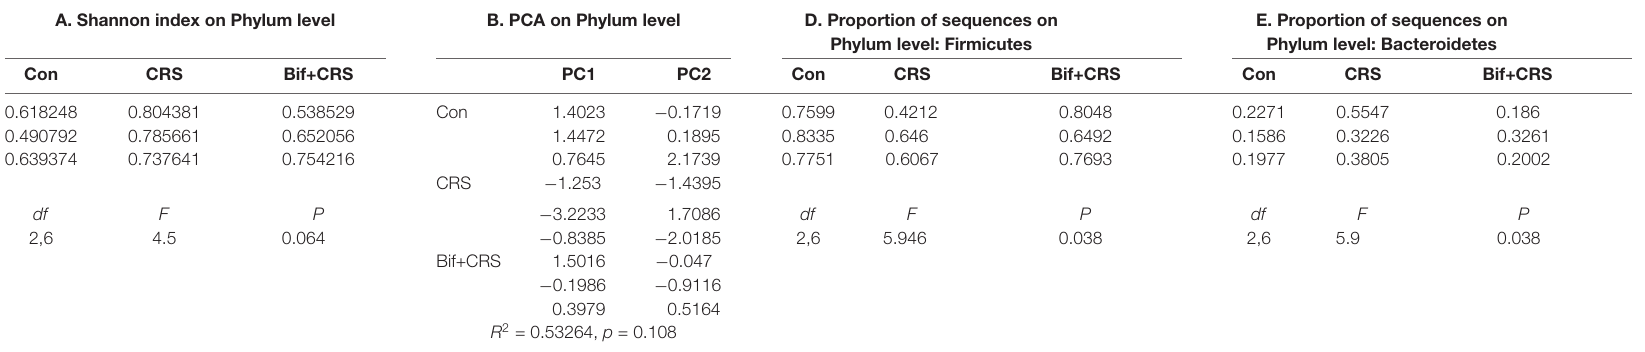
TABLE 3 | B. adolescentis reversed the imbalance of the intestinal microflora induced by CRS at the phylum level.